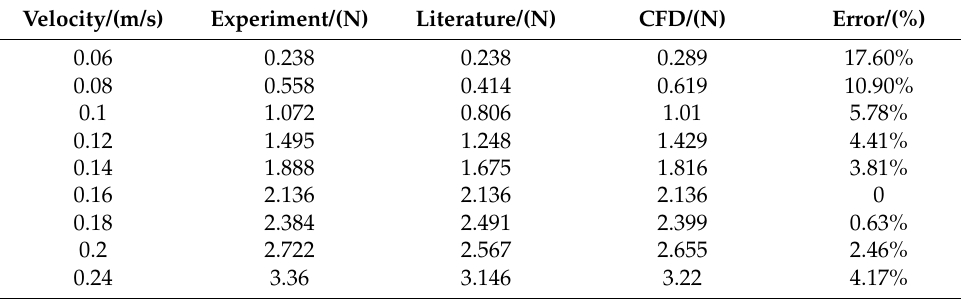
Table 1. The experimental results for resistance of the box-shaped